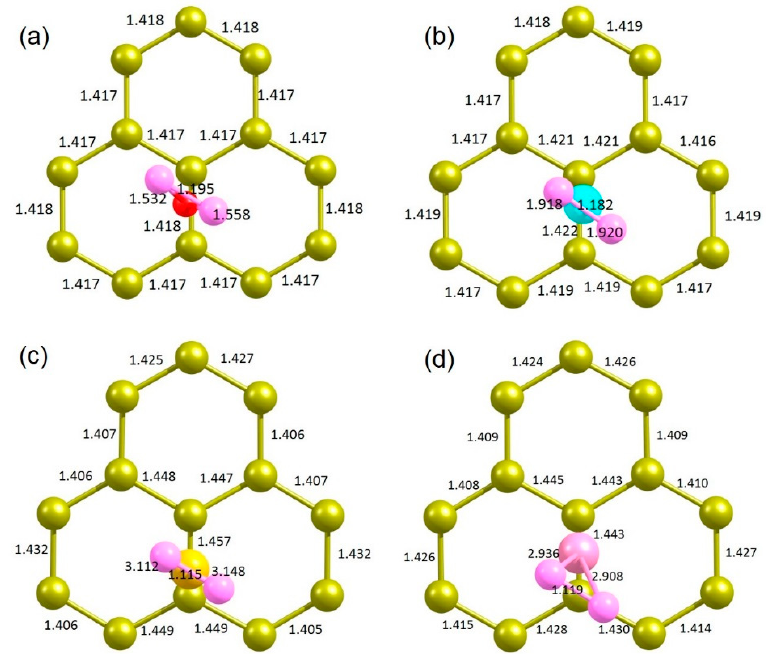
Figure 6. Relaxed structures of N 2 interacting with ( a ) O, ( b ) S, ( c ) Se and ( d ) Te adsorbed onto the graphene.